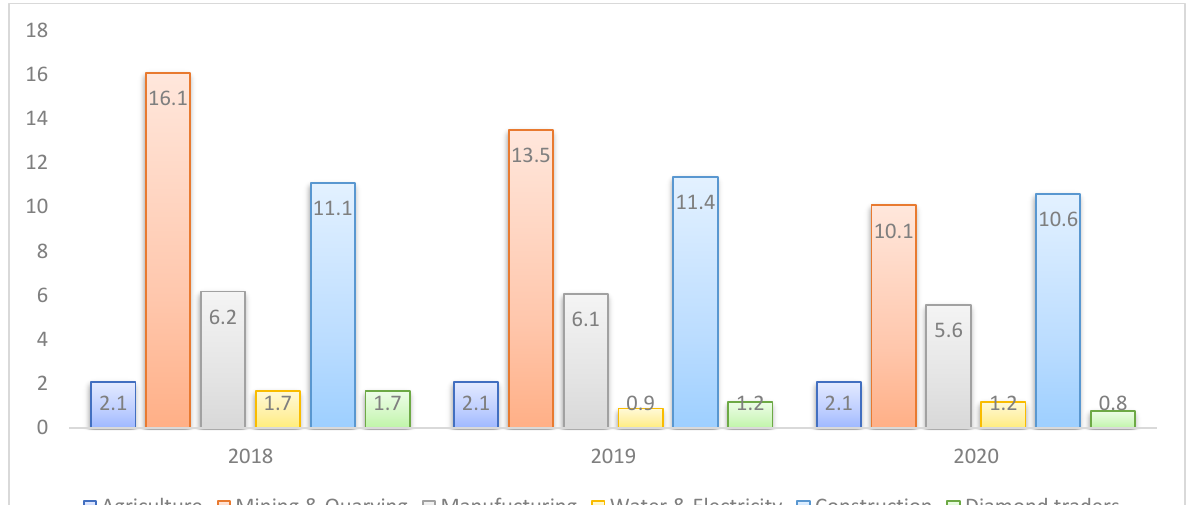
Figure 2. Distribution of GDP by Economic Activity (percentage of GDP). Source: Statistics Botswana [41].